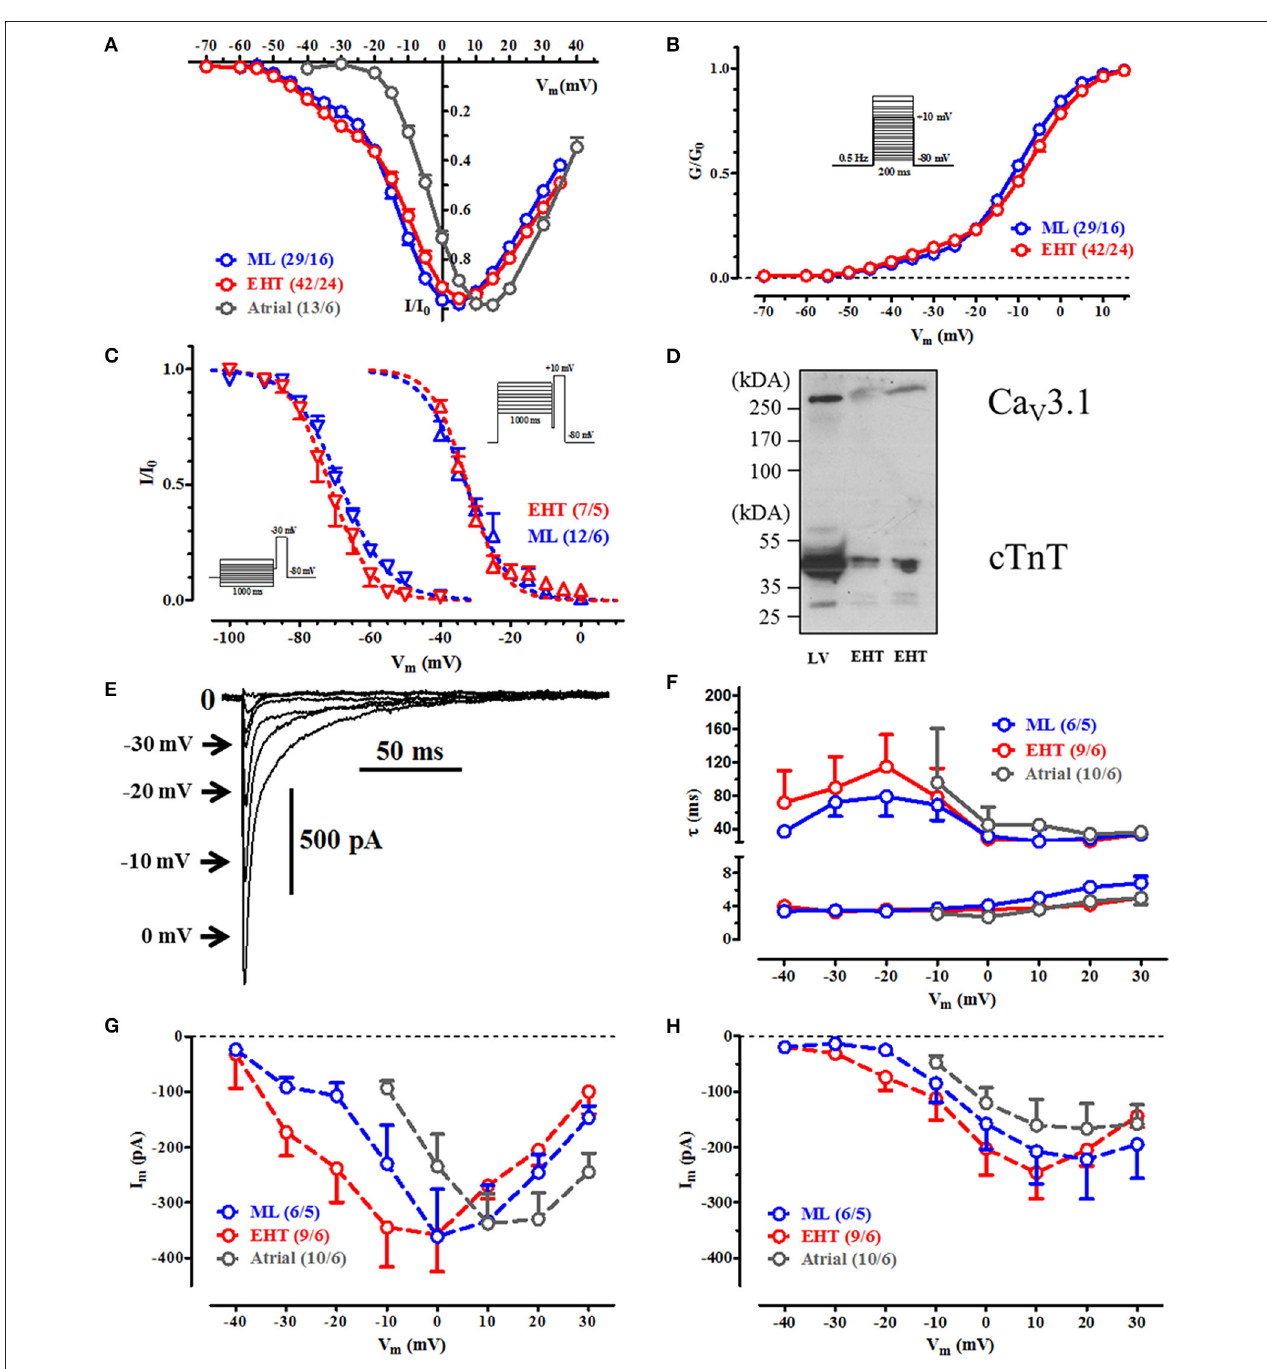
FIGURE 2 | Voltage dependency of current activation, steady state inactivation and inactivaton during a test-pulse. (A) IV-curves for ML, EHT, and atrial CM. Currents are normalized to its individual maximum. (B) Activation curves for ICa. Conductances were calculated from individual IV-curves. (C) Steady state inactivation curves for T-type Ca 2 + -channels (at − 30 mV, left) and for L-type (at + 10 mV, right). (D) Western blot with antibodies against CaV 3.1 and cardiac troponin T (cTnT; loading control) in human adult left ventricle (LV) and engineered heart tissue (EHT). (E–H) Time-dependent inactivation of Ca 2 + -currents. (E) Original tracings of ICa during initial inactivation phase at different test pulse potentials in hiPSC-CM (For pulse protocol, compare inset in (B) . Numbers next to the arrows indicate respective test pulse potential, for clarity some steps were omitted). (F) τ -values for the fast and slow inactivation phase and respective current amplitudes obtained by curve fitting at different test-pulse potentials A (G) and B (H) . Please note that in human atrial CM no Ca 2 + -currents could be recorded at Vm < − 10 mV. For details see Table S5. N/N indicates number of cells vs. number of isolation for ML and EHT and number of cells/number patients for atrial CM.